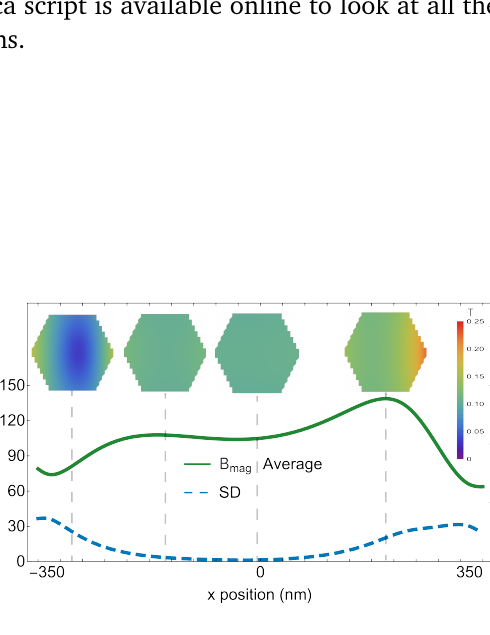
Figure 16: A X-Y plane heat map for magnetic field magnitude in a small region near the nanowire, the magnet areas have been set to 0 field (black triangular regions). This is for a 5 nm thick slice in the middle where the nanowire is (marked by red lines). A Mathematica script is available online to look at all the different X-Y slices at different z-positions.